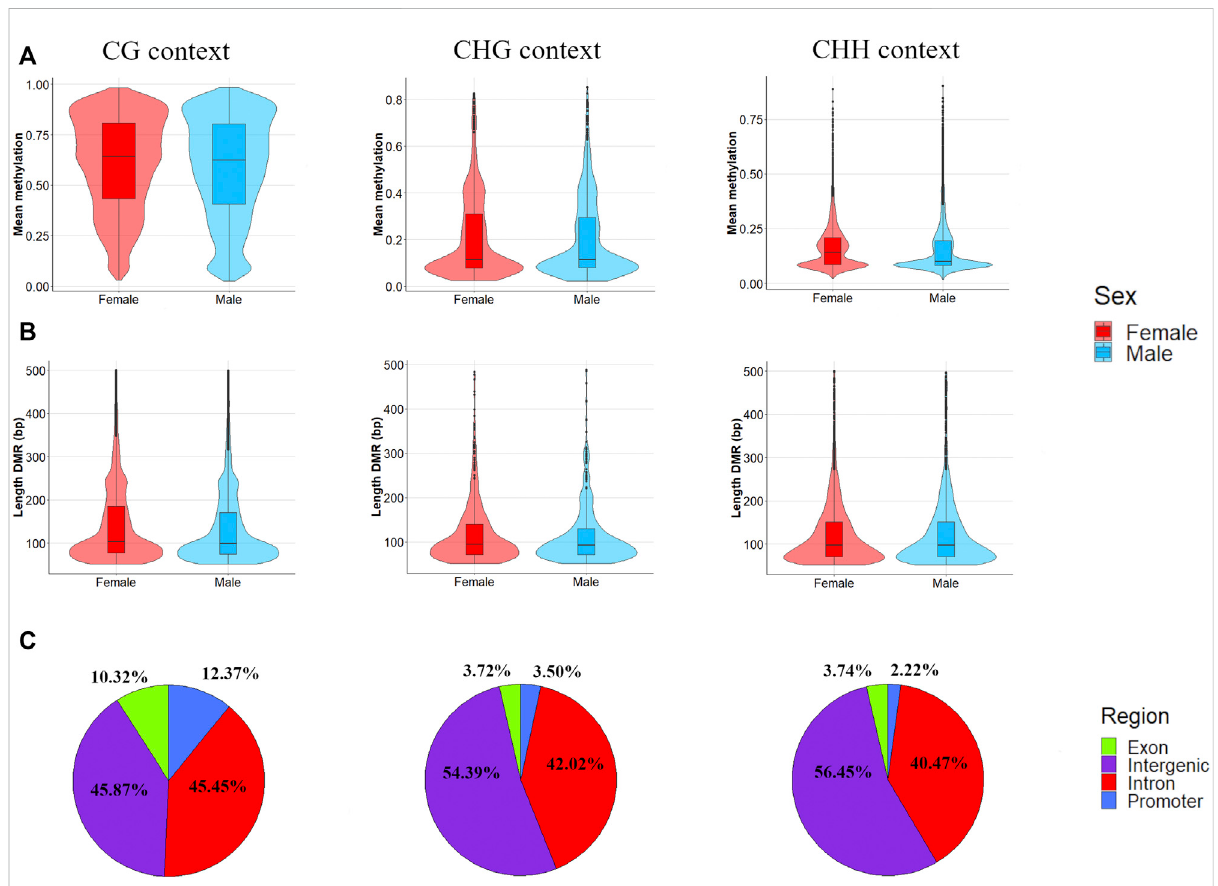
FIGURE 3 Distribution of (A) mean methylation level (B) length, and (C) genomic context (exon, intergenic, intron or promoter region) for the differential methylation regions (DMRs) detected between males and females in Assaf suckling lambs. (A) Violin plots showing the distribution of mean methylation levels within DRMs in the three methylation contexts (CG, CHG and CHH) and between males (in blue) and females (in red). (B) Violin plots showing the distribution of the DMR lengths in the three methylation contexts (CG, CHG and CHH) and between males (in blue) and females (in red). The length of DMRs was truncated at 500 bp for all three contexts to obtain a clear visualization of the distributions. (C) Pie plots showing the percentage of DMRs detected within each genomic context (intergenic, exon, intron and promoter).